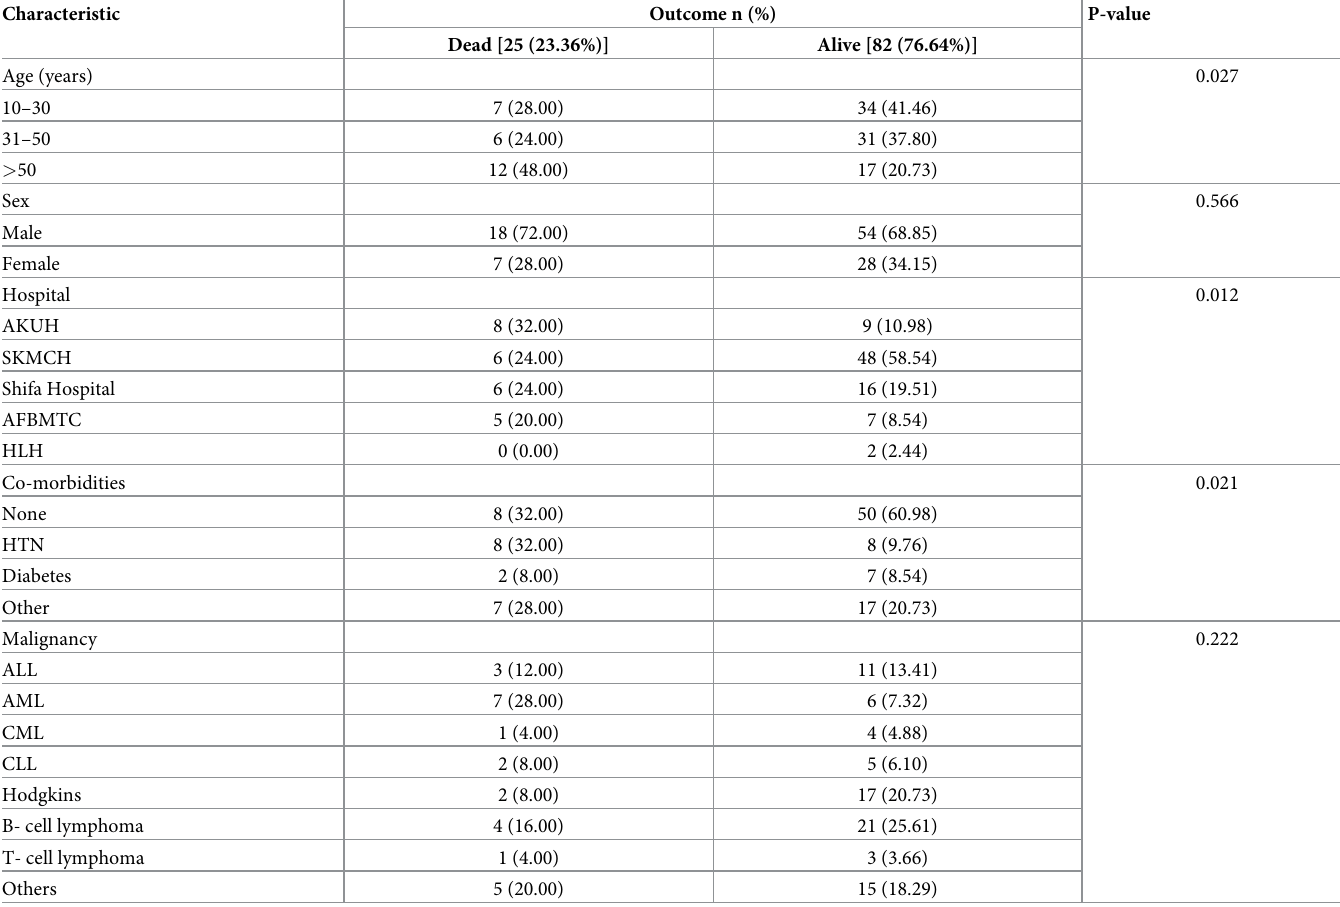
Table 1. Baseline and clinical characteristics of patients with hematological malignancies and COVID-19 stratified on the outcome (n = 107).